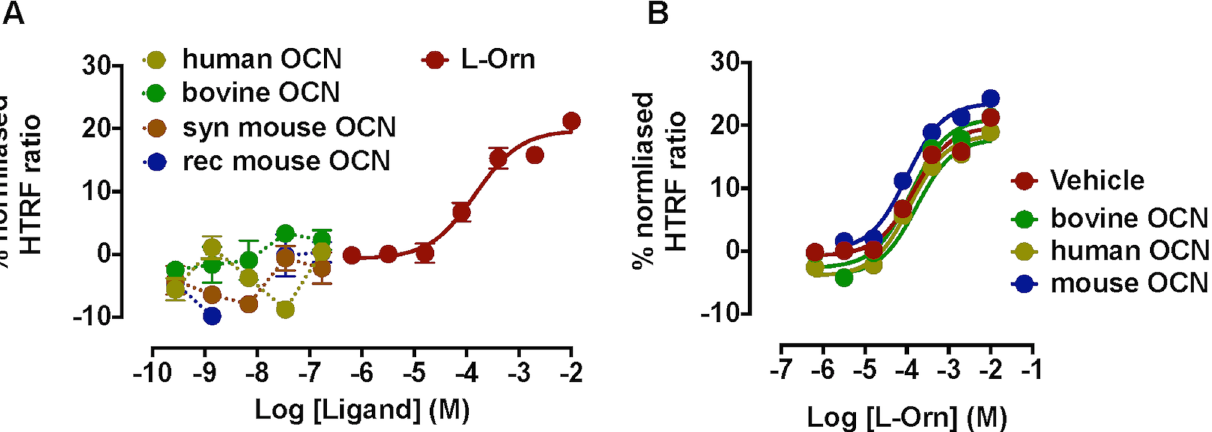
Fig 2. Effect of OCN on inositol phosphate accumulation in FlpIn-TREx-HEK293-mGPRC6A cells. (A) Variants of the putative GPRC6A peptide ligand osteocalcin (OCN) fail to induce inositol phosphate accumulation in FlpIn-TREx-HEK293-mGPRC6A cells co-expressing G α qG66D . (B) OCN variants (40 ng/ ml) do not modulate L-ornithine-stimulated inositol phosphate accumulation at mGPRC6A (OCN variants as described in Table